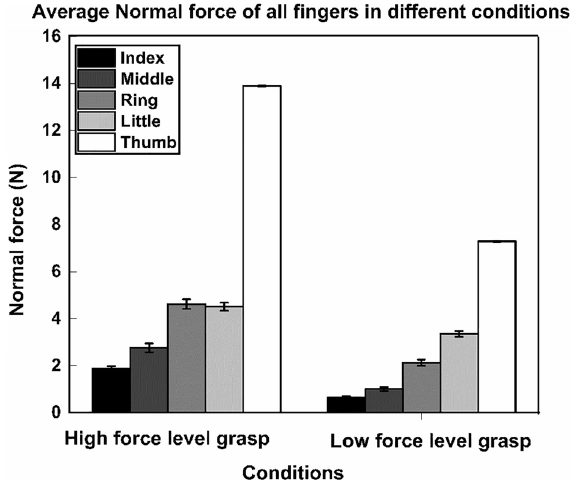
Figure 3. Average Normal forces of the individual fingers and thumb in different conditions. Little finger normal force (represented in light shaded gray) of high force level grasp condition was statistically equivalent to the ring finger normal force (represented in medium shaded gray) of the same condition. In contrast, during low force level grasp condition, little finger normal force (represented in light shaded gray) was statistically greater (p < 0.001) than the ring finger normal force (represented in medium shaded gray). During high force level grasp condition, the average thumb normal force (mean = 13.89 N, SD = 0.07) produced by the participants was statistically greater (p < 0.001) than the average thumb normal force (mean = 7.28 N, SD = 0.09) produced during low force level grasp